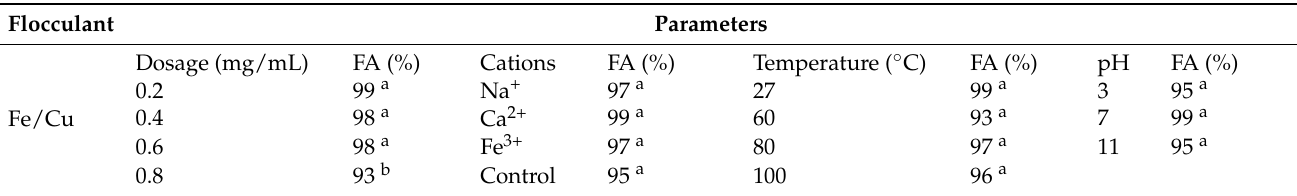
Table 3. Effect of different parameters on flocculation activity (FA) of bimetallic nanoparticles.